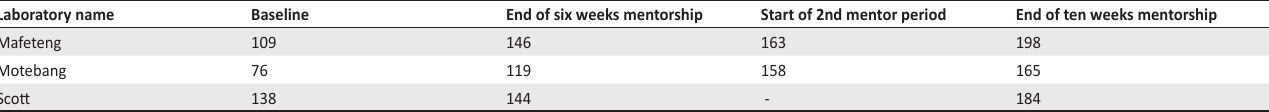
TABLE 5: Assessment scores at specific time points during the mentorship periods at three district laboratories in Maseru,